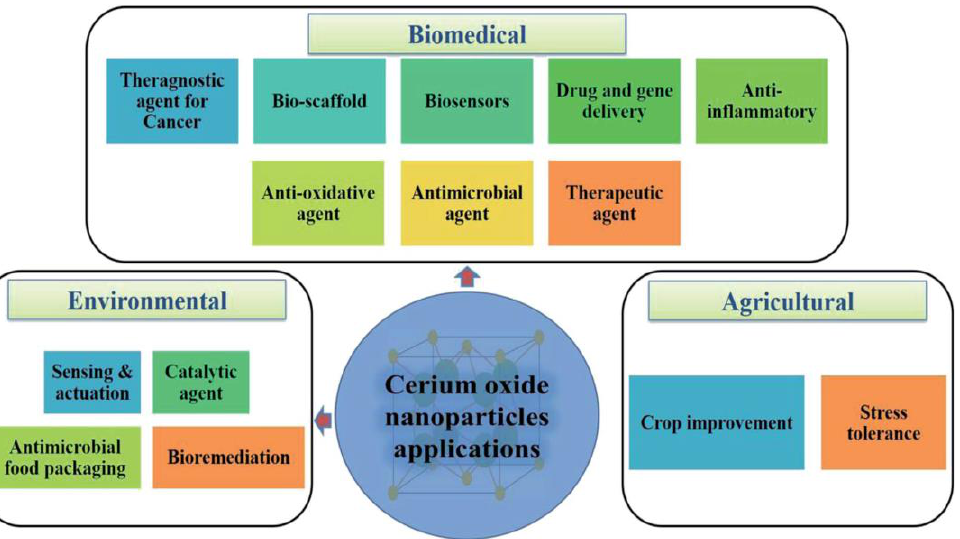
Figure 1. The uses of ceria in various fields. Reproduced with permission from Ref. [9]. Copyright© 2020, Royal Society of Chemistry.